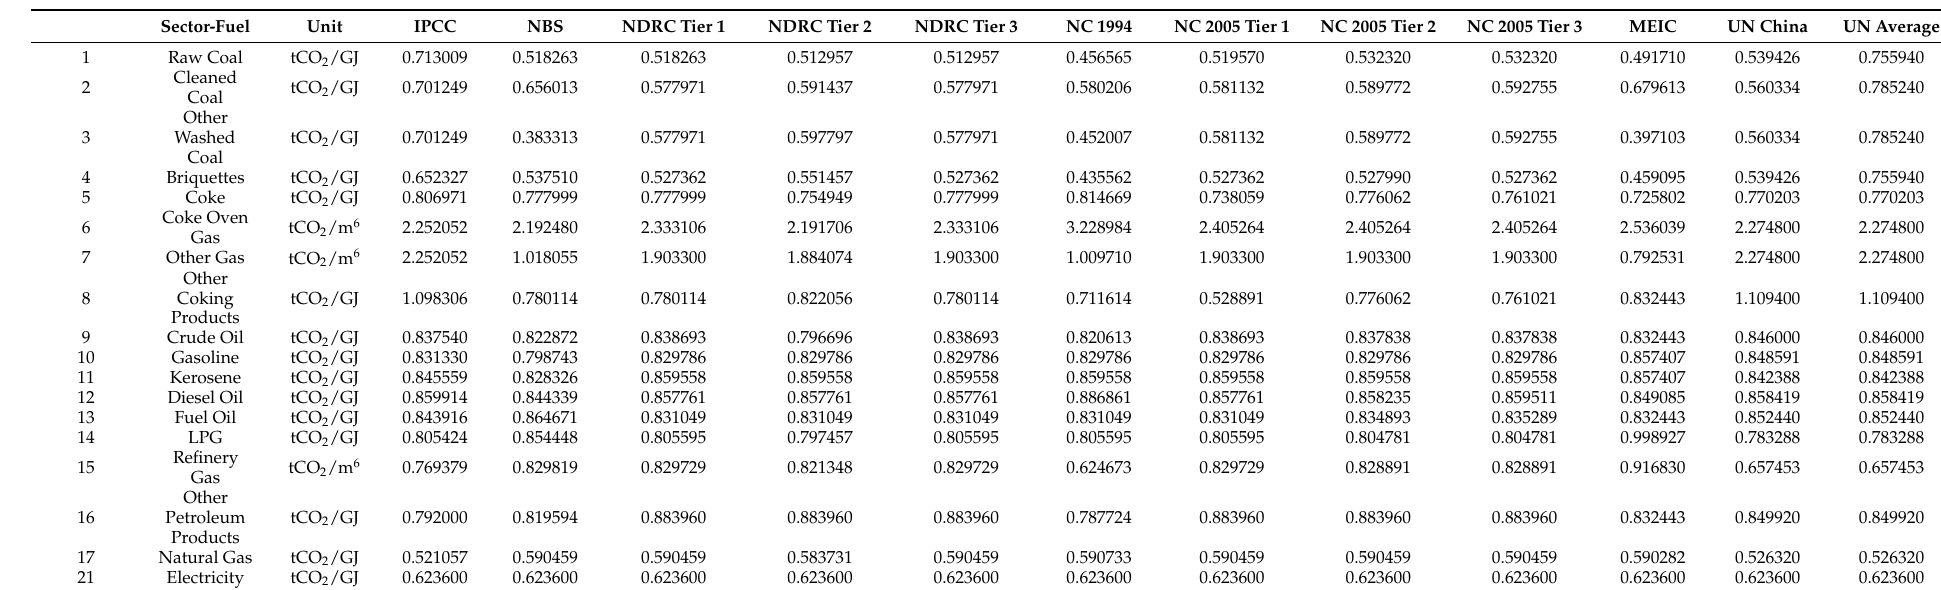
Table 2. Emission factors for fuels specific to China’s construction